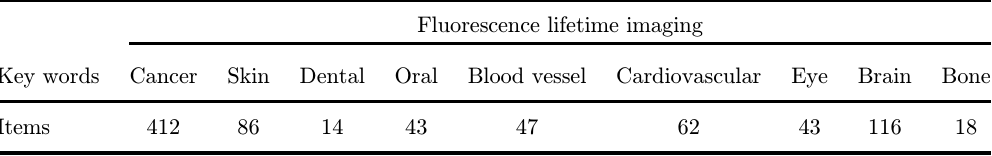
Table 1. Retrieval results of °uorescence lifetime imaging in tissues and